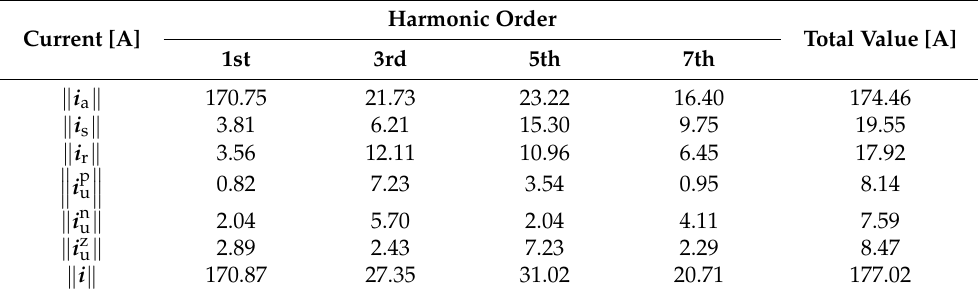
Figure 5. The analyzed system with connected minimizing balancing compensators (MBC). Table 6. List of the values of the three-phase currents’ components after the minimizing balancing compensation.